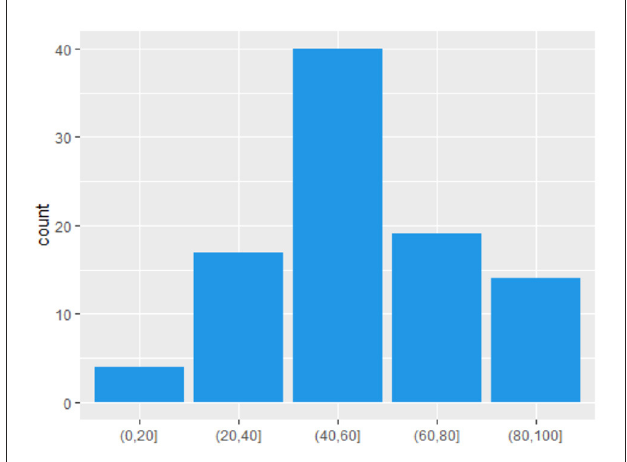
FIGURE3 Overall score distribution in five levels of performance.